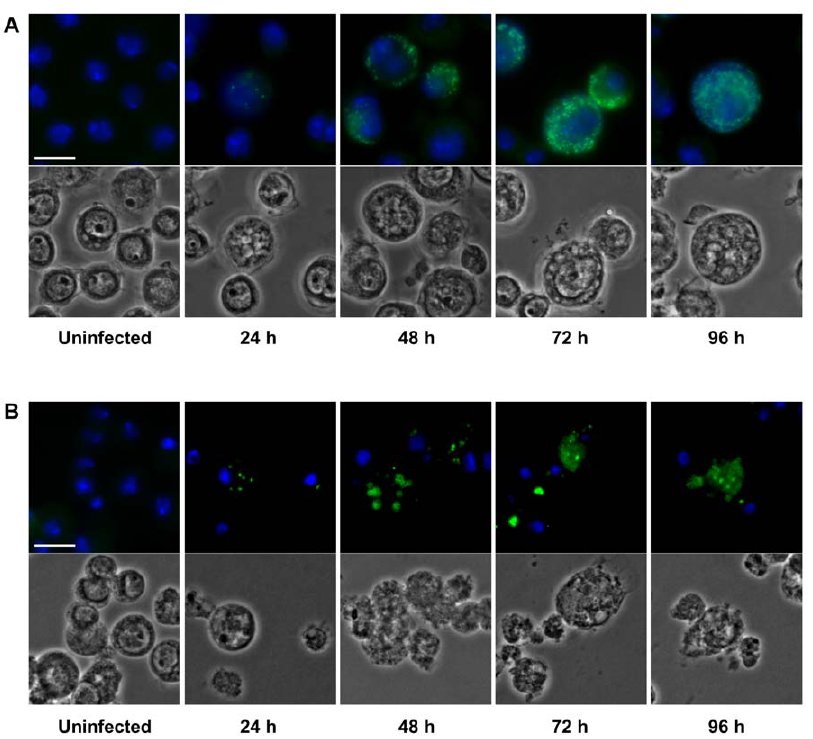
Figure 2. Infection cycle of S.negevensis (A) and Pa.acanthamoebae (B) in S2 cells. S2 cells were either left untreated or were infected with S. negevensis (MOI 5) (A) or Pa. acanthamoebae (MOI 0.5) (B). At indicated time points, bacteria were visualized by immunostaining (green) using antibodies raised against the protochlamydial heat-shock protein DnaK (A) or purified Pa. acanthamoebae UV7 (B). DNA was stained with DAPI (blue). The bar corresponds to 10 m